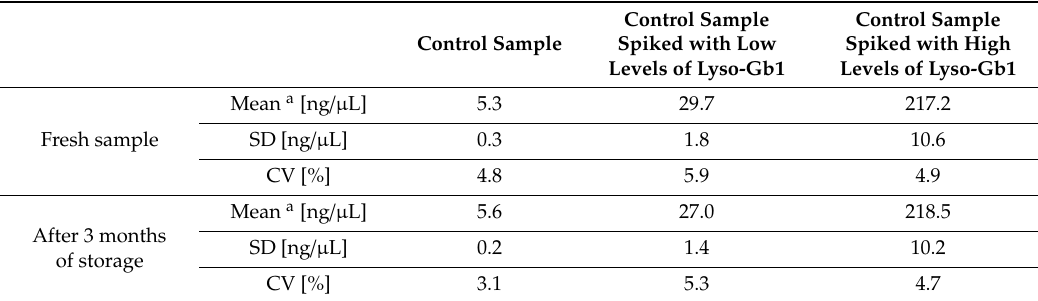
Table 1. Precision for determination of glucosylsphingosine (Lyso-Gb1) from dried blood spot (DBS) samples.